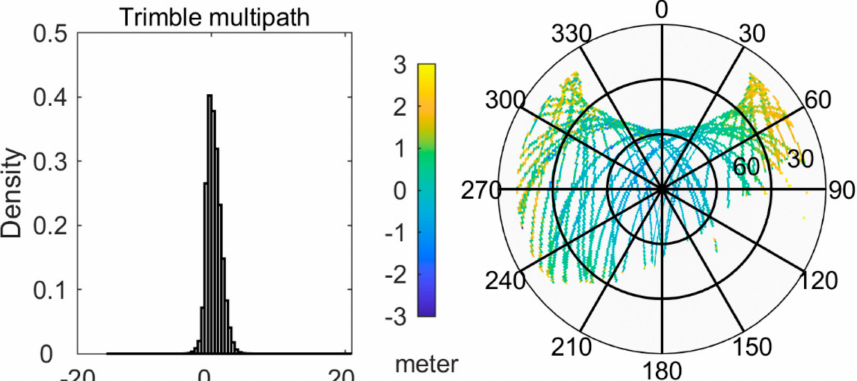
Figure 9. The probability density histogram( left ) and sky map( right ) of the multipath error of day of year (DOY) 50.